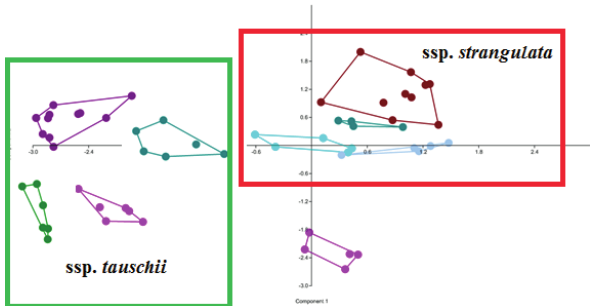
Figure 6. PCA plot of Ae. tauschii populations based on morpho- logical characters. Numbers are according to Table